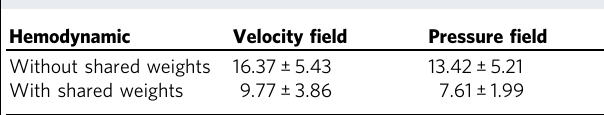
Table 5 Comparison of MRE from network with or without shared